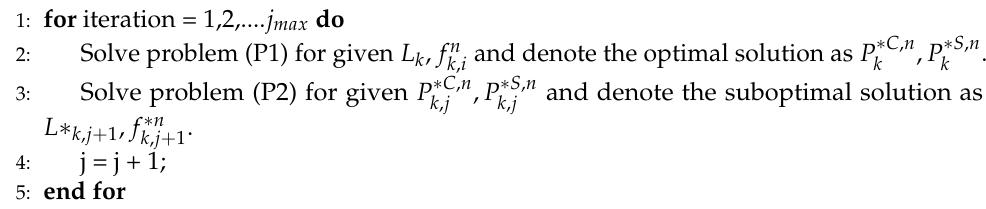
Algorithm 2 The Proposed Alternating Optimization Algorithm to Solve Problem